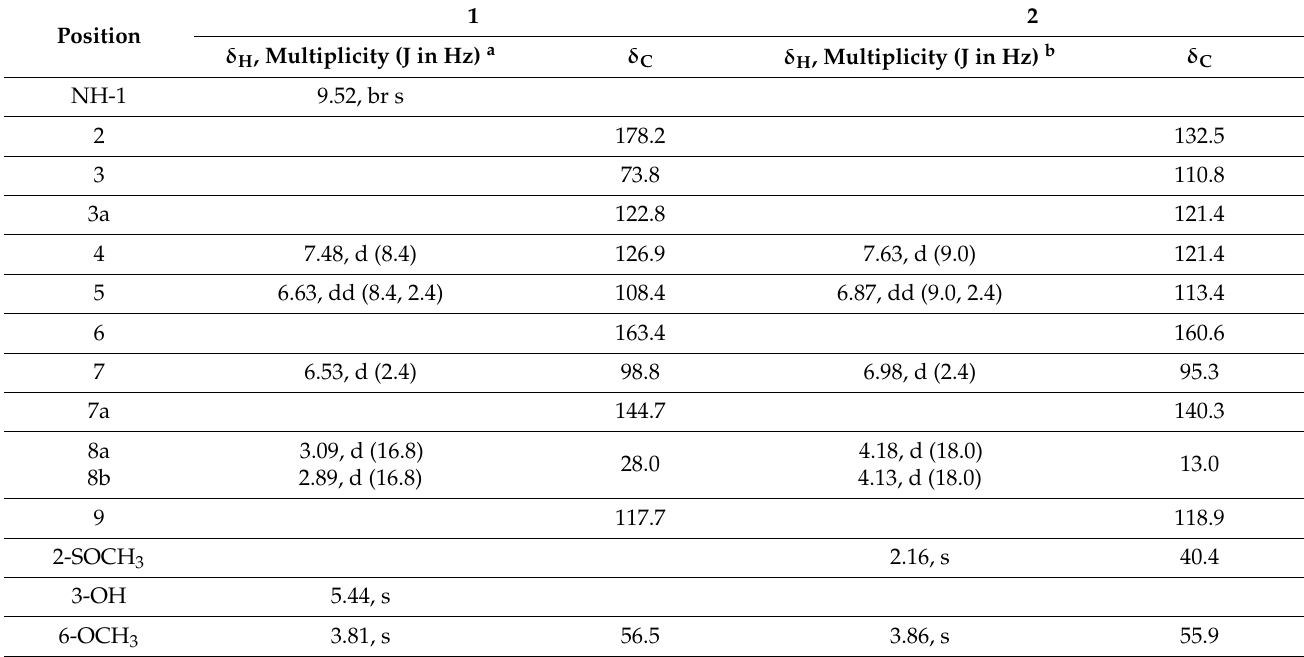
Table 1. 1 H- and 13 C-NMR data for compounds 1 – 2 .